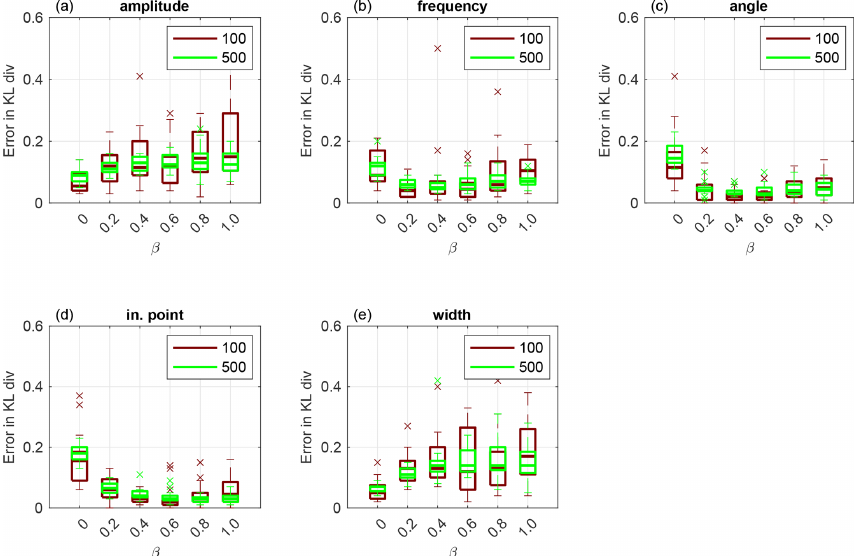
Figure 5. The same as Fig. 4 but using optimal transport